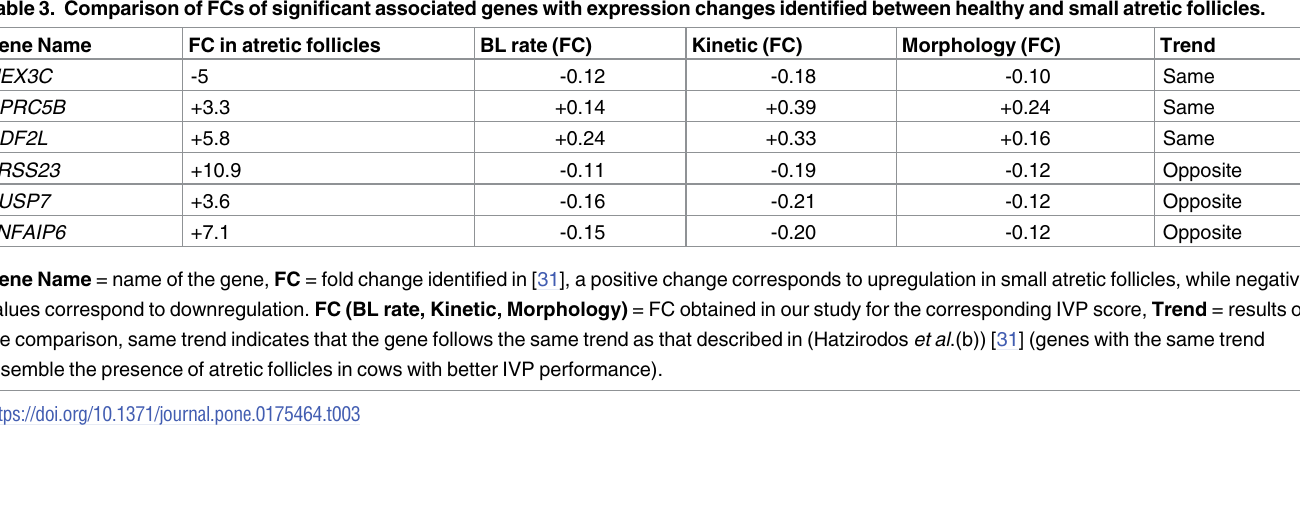
Table 3. Comparison of FCs of significant associated genes with expression changes identified between healthy and small atretic follicles.